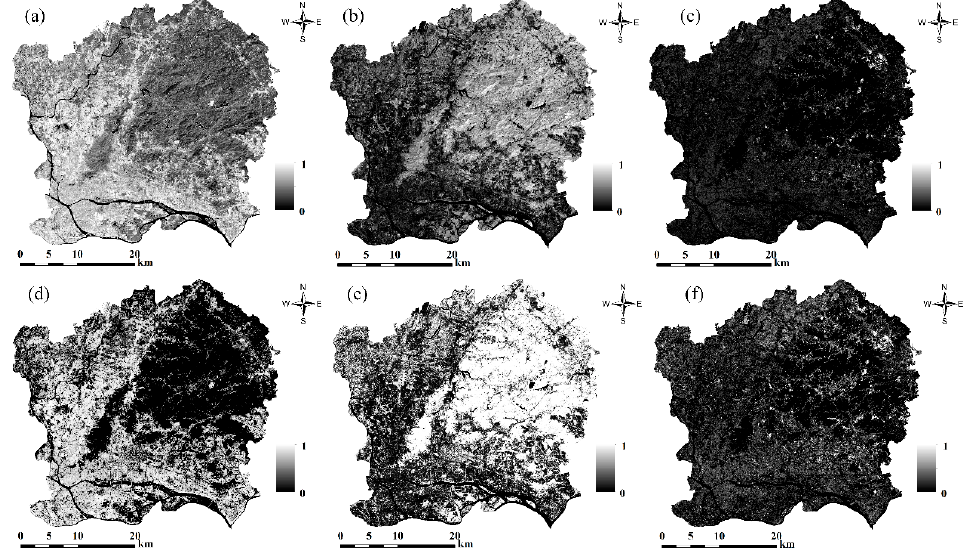
Figure 6. Extracted results of the conventional ( a – c ); and modified LSMA ( d – f ) methods: ( a , d ) impervious surface; ( b , e ) vegetation; and ( c , f ) soil fractions.